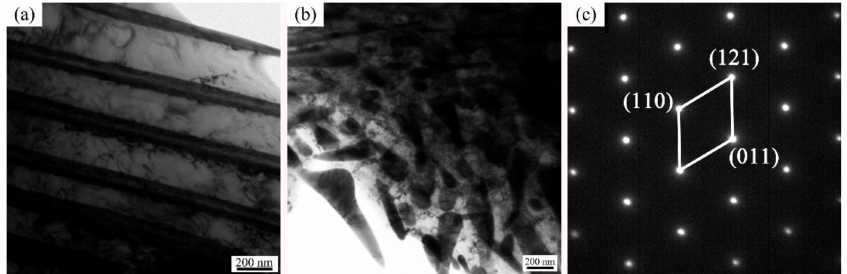
Figure 11. TEM images of the SA106B low-carbon steel. ( a ) RASP-processed for 0 min; ( b ) RASP-processed for 5 min; ( c ) The corresponding selected-area electron diffraction (SAED) pattern in